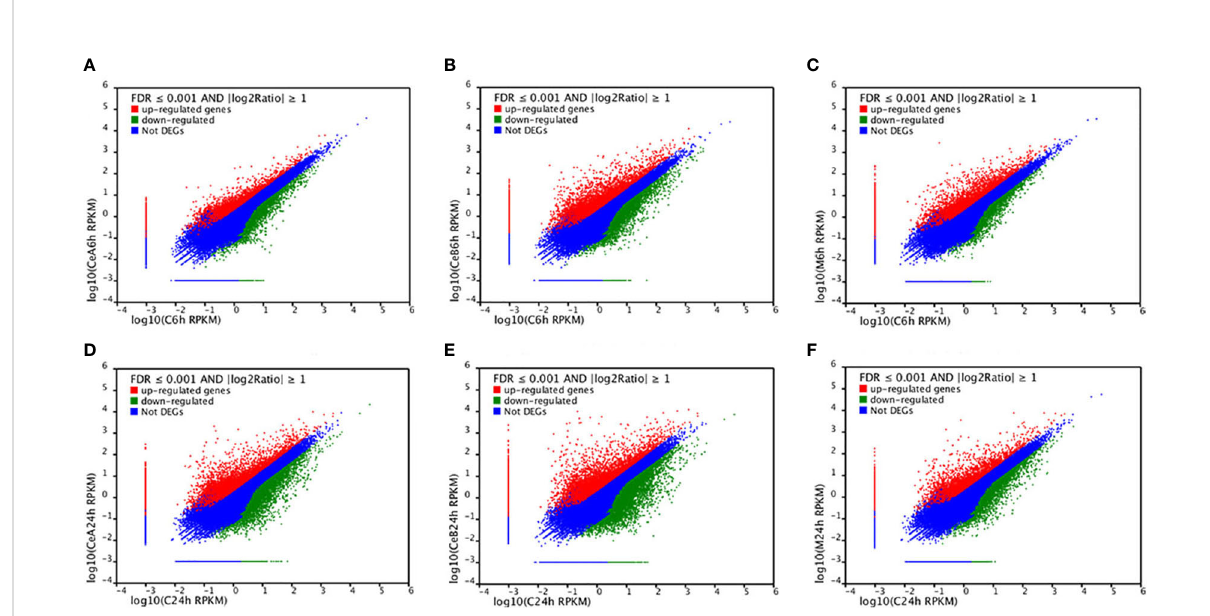
FIGURE 3 Expression levels in the six comparisons including C6h-vs-CeA6h (A) , C6h-vs-CeB6h (B) , C6h-vs-M6h (C) , C24h-vs-CeA24h (D) , C24h-vs- CeB24h (E) and C24h-vs-M24h (F) . The red points represent upregulated unigenes, the green points represent down-regulated unigenes, and the blue points represent non-DEGs